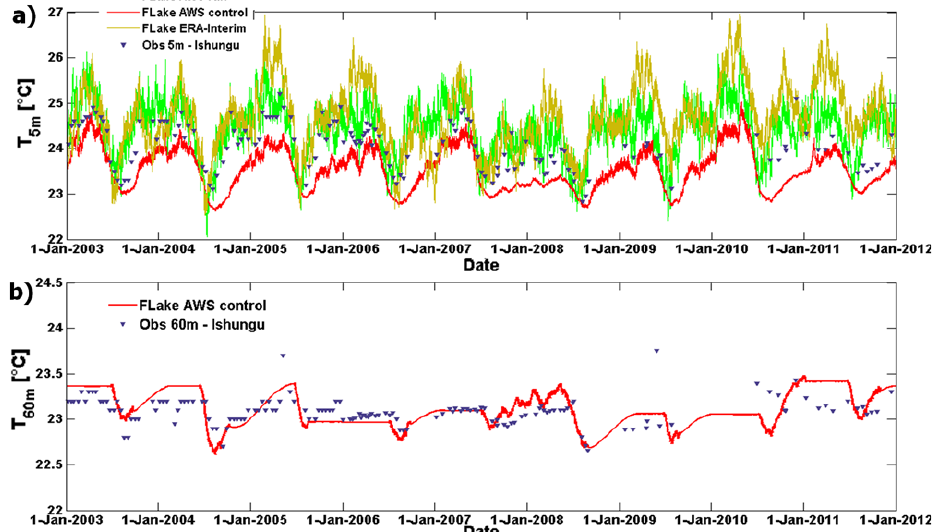
Fig. 4. Modelled and observed temperature evolution at Ishungu (Lake Kivu) at (a) 5m, and (b) 60m depth. FLake temperatures at 60m predicted by the raw and ERA-Interim integration are omitted as they are constant at 3.98 ◦